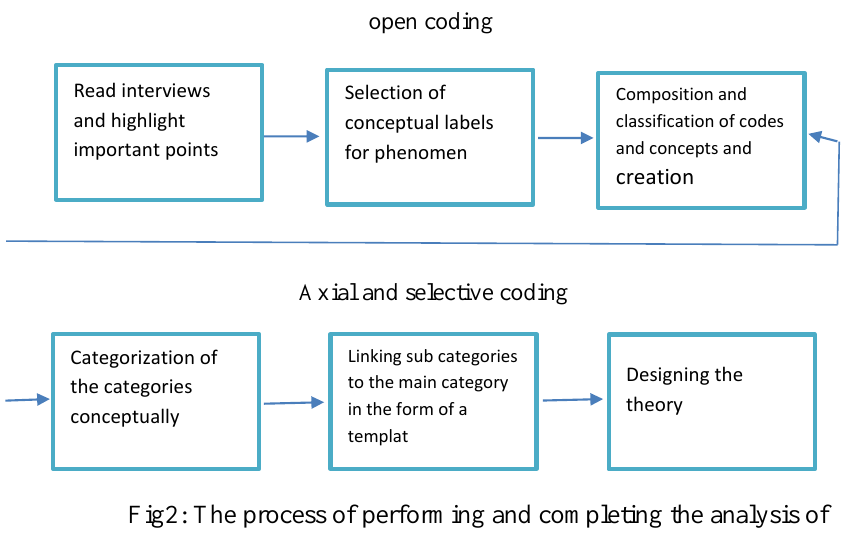
Fig2: The process of performing and completing the analysis of research